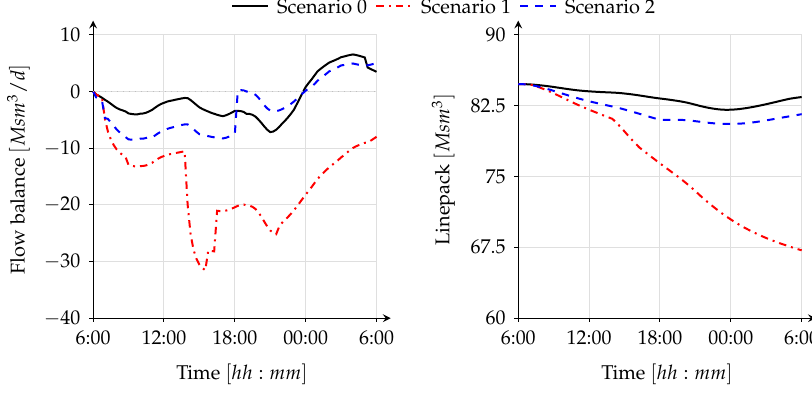
Figure 11. Time evolution of flow balance (sum of inflow minus sum of outflow) and line pack for the computed scenarios.